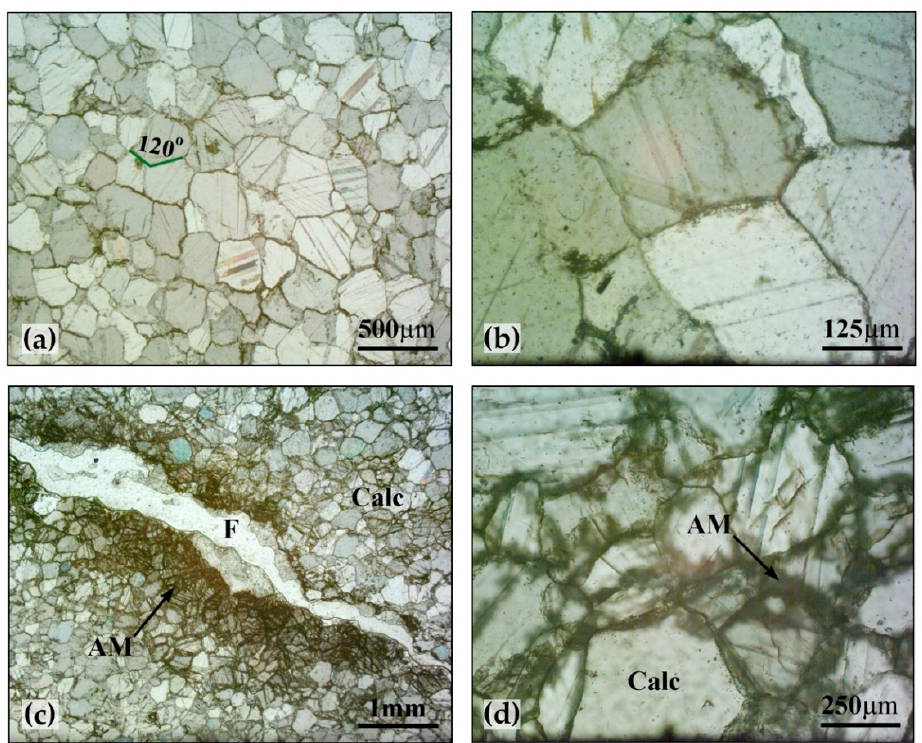
Figure 3. Petrographic thin section images. ( a ) Granoblastic texture of the marble and contact angle (120°) between the calcite crystals. Cross polarised light; ( b ) detail of well welded boundaries among calcite crystals. Cross polarised light; ( c ) alteration material (AM) concentrated on the edges of a fracture (F). Calc (calcite). Cross polarised light; ( d ) detail of a fractured sector characterised by the alteration material (AM) and dirt between calcite crystals (Calc). Cross polarised light.